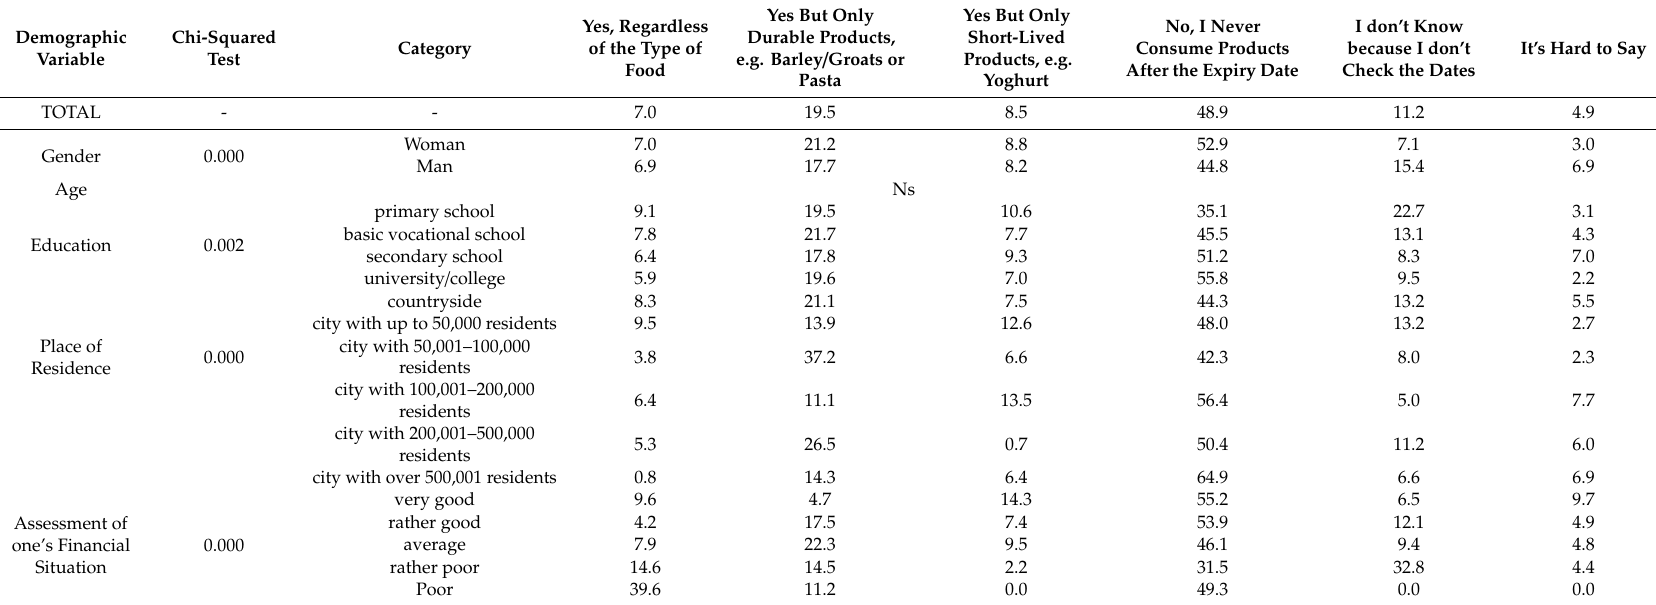
Table 3. Consumer declarations on consumption after the expiry date